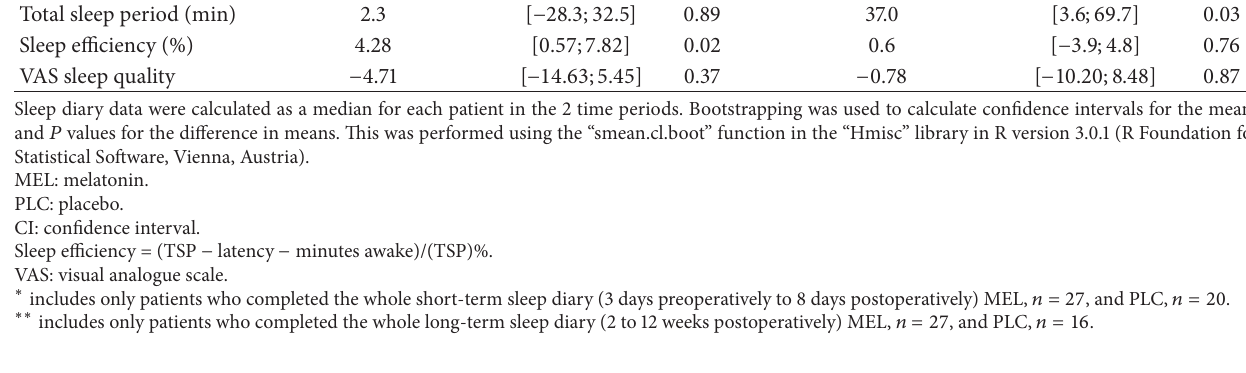
Table 4: Sleep latency, number of awakenings, total sleep period, sleep efficiency, and VAS sleep quality for the melatonin versus placebo in the short-term perioperative and the long-term postoperative period.